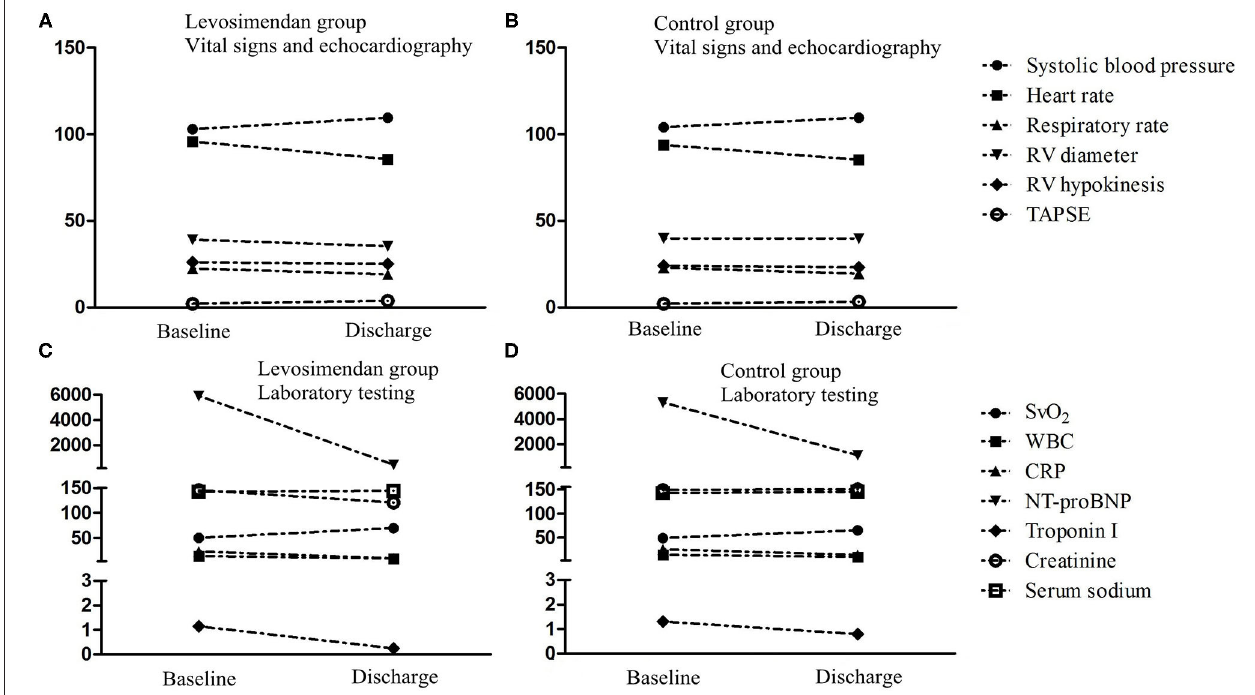
FIGURE 3 | Changes of clinical characteristics from baseline to discharge. SvO 2 , oxygen saturation of mixed venose blood; WBC, white blood cell; CRP, C-reactive protein; NT-proBNP, N-terminal pro-B type natriuretic peptide; eGFR, estimated glomerular filtration rate; TAPSE, tricuspid annular plane systolic excursion; RV, right ventricle; RVSP, right ventricular systolic pressure. (A) Vital signs and echocardiography in levosimendan group. (B) Vital signs and echocardiography in control group. (C) Laboratory testing in levosimendan group. (D) Laboratory testing in control group.